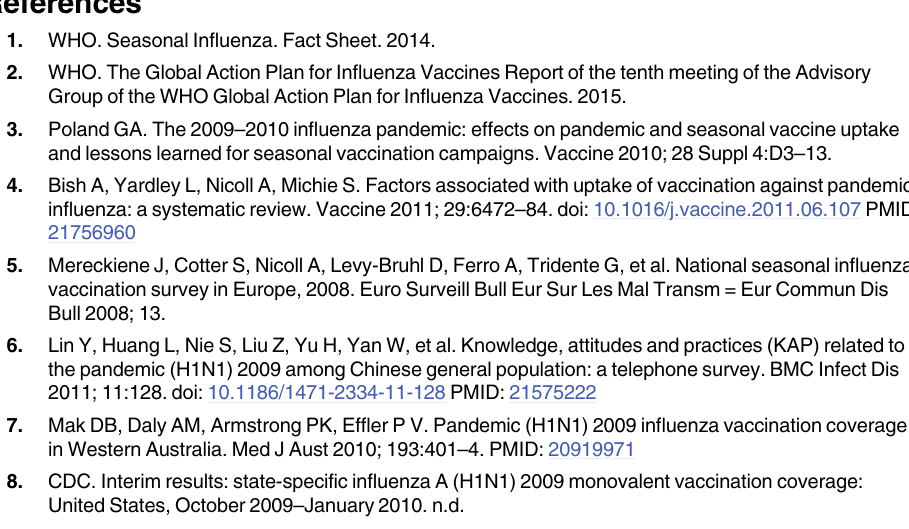
S2 Table. Measurement of constructs of the Theory of Planned Behavior (TPB) and its extensions. S3 Table. PRISMA